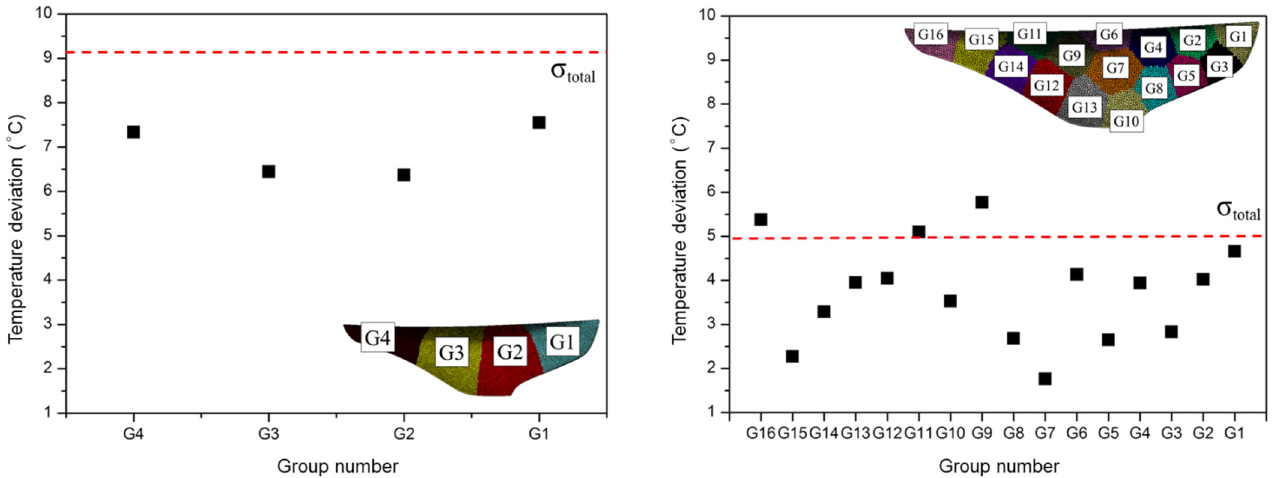
Figure 14. The standard deviation of temperature by area and overall of the second ( Left ) and third ( Right ) generation.